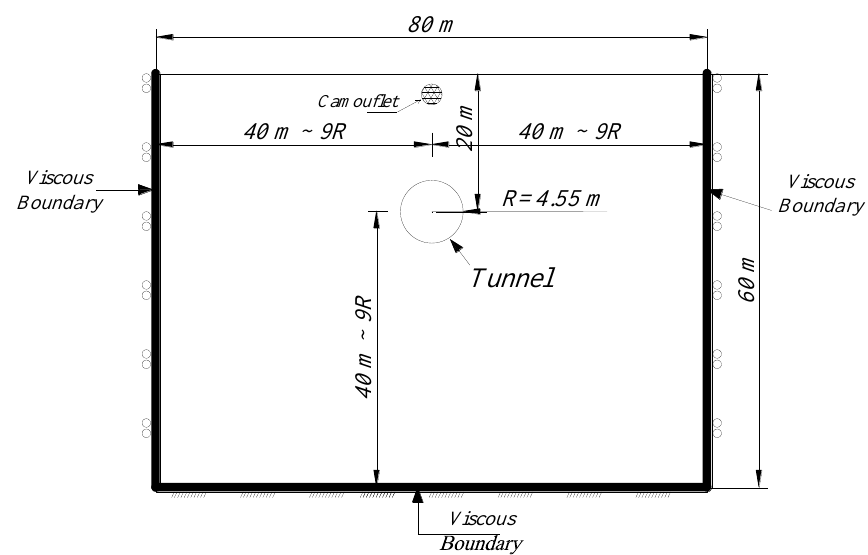
Fig. 1. Model size and boundary conditions in the numerical model in order to simulate the effect of blast loading (in the camouflet) over the